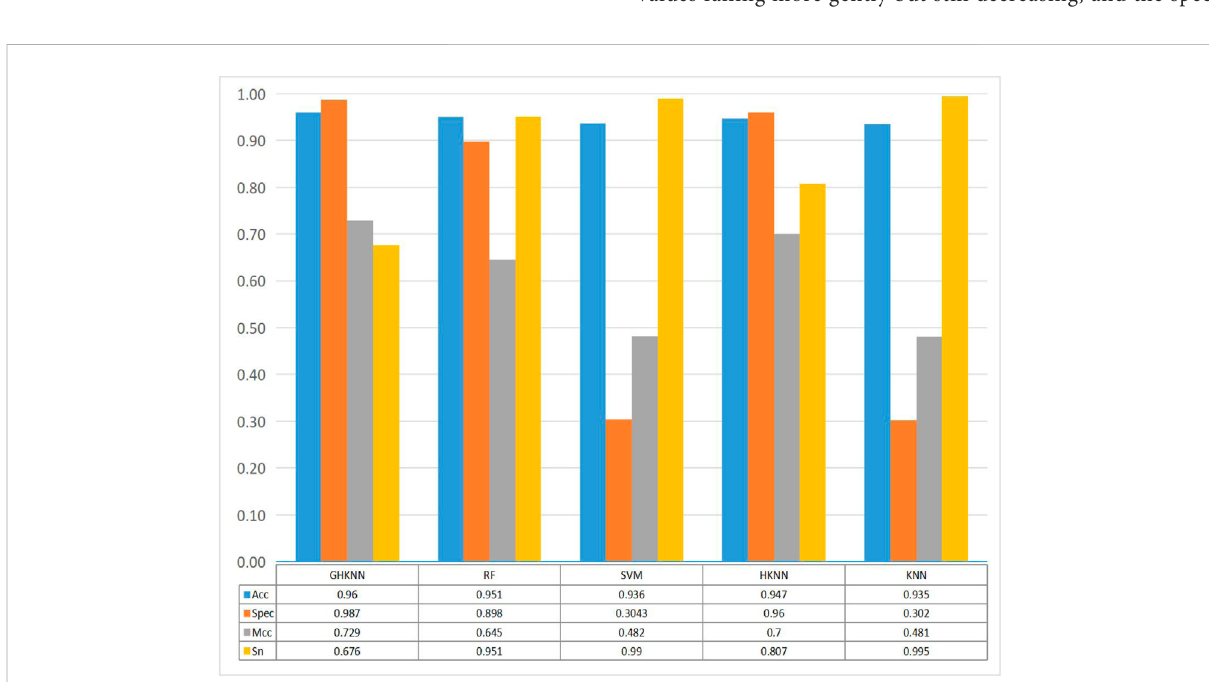
FIGURE 3 Histogramsofthefourmetrics,namely,sn,acc,specandmcc,obtained fromtheclassi fi cationofthedatasetbythe fi veclassi fi ers:GHKNN,RF, SVM, HKNN, and